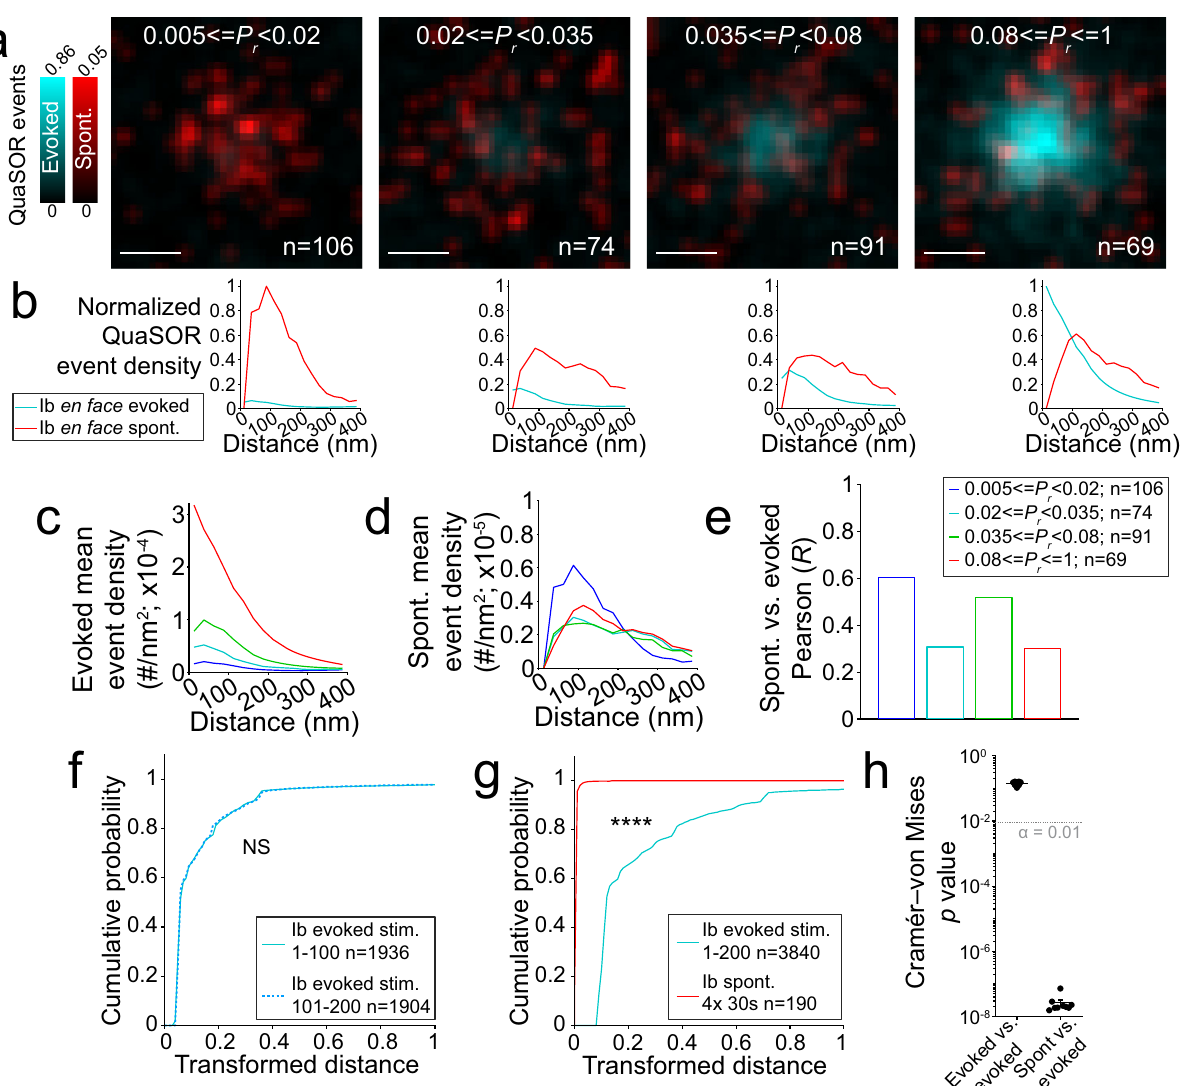
Fig. 4 Evoked and spontaneous transmission are spatially mismatched. a Evoked and spontaneous average event densities across P r . P r -binned, aligned and averaged en face classi fi ed QuaSOR spatial patterns for evoked-active Ib AZs showing both evoked (cyan) and spontaneous (red) events ( σ = 21.2 nm). b QuaSOR radial event density pro fi les across P r . P r -binned, normalized en face radial mean evoked and spontaneous density pro fi les for event distributions in a . Normalization is calculated from the maximum pro fi le density for each event type. c , d Aligned P r -binned en face -de fi ned radial mean event density pro fi les for evoked ( c ) and spontaneous ( d ) events. e Spatial decoupling of evoked and spontaneous radial pro fi les. Pearson correlation coef fi cients ( R ) for evoked versus spontaneous P r -binned en face -de fi ned radial mean density pro fi les for each evoked-active P r bin in a – d . f Global evoked pattern stability across stimulus trials. Representative transformed distance distributions for a single NMJ (example in Suppl. Fig. 6) comparing evoked event coordinates from stimuli 1 – 100 (solid; n = 1936 events) to evoked coordinates from stimuli 101 – 200 (dashed; n = 1904 events; Cramér – von Mises p = 0.14). g Global spontaneous and evoked pattern decoupling. Representative transformed distance distributions for the same NMJ in f comparing evoked event coordinates from all stimuli 1 – 200 (cyan; n = 3840 events) versus all spontaneous event coordinates (red; n = 190 events; two-sample two-sided Cramér – von Mises test p = 1.56 × 10 − 7 ). h Global decoupling of evoked and spontaneous release. Pooled two-sample two-sided Cramér – von Mises test p values for evoked fi rst half versus evoked second half ( f ) and all evoked stimuli versus spontaneous ( g ) cumulative distributions for multiple WT NMJs ( n = 9 NMJs). The dotted line indicates an α = 0.01. Scale bars: 200 nm ( a